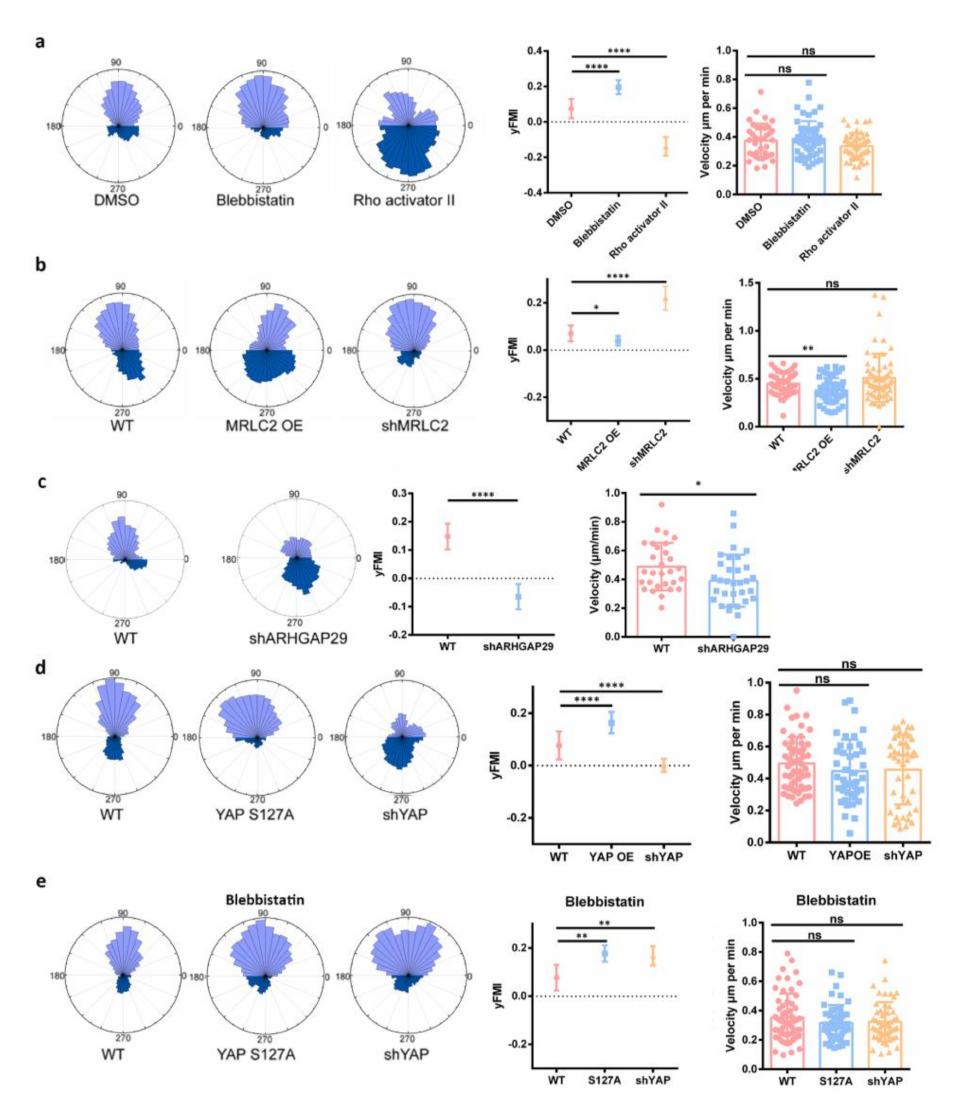
Figure 2. YAP promotes negative durotaxis through ARHGAP29-RhoA-Myosin II. ( a ) Left: Rose plots of B16 F1 cell migration on stiffness gradient PA gel after treated with DMSO/blebbistatin/Rho activator II. Right: yFMI, velocity of B16 F1 cell migration on stiffness gradient PA gel after treated with DMSO/blebbistatin/Rho activator II, n DMSO = 38, n blebbistatin = 53, n Rho activator II = 51, error bar is SD, ****, p < 0.0001, by one-way ANOVA, ns, none significant, by student’s t test. ( b ) Left: Rose plots of B16 F1 WT/MRLC2 OE/shMRLC2 cell migration on stiffness gradient PA gel. Right: yFMI, velocity of B16 F1 WT/MRLC2 OE/shMRLC2 cell migration on stiffness gradient PA gel,n WT = 46, n MRLC2 = 53, n shMRLC2 = 59, error bar is SD, ****, p < 0.0001, **, p < 0.01, *, p < 0.05,ns, no significant difference, by one-way ANOVA, ns, none significant, by student’s t test. ( c ) Left: Rose plots of B16 F1 WT/shARHGAP29 cell migration on stiffness gradient PA gel. Right: yFMI, velocity of B16 F1 WT/shARHGAP29 cell migration on stiffness gradient PA gel, n WT = 29, n shARHGAP29 = 32 error bar is SD, by student’s t test. ( d ) Left: Rose of B16 F1 WT/YAP S127A/ shYAP cell migration on stiffness gradient PA gel; Right: yFMI, velocity of B16 F1 WT/YAP S127A/shYAP migration on stiffness gradient PA gel, n WT = 57, n S127A = 42, n shYAP = 45, error bar is SD, ****, p < 0.0001, *, p < 0.05, by one-way ANOVA, ns, none significant, by student’s t test. ( e ) Left: Rose of B16 F1